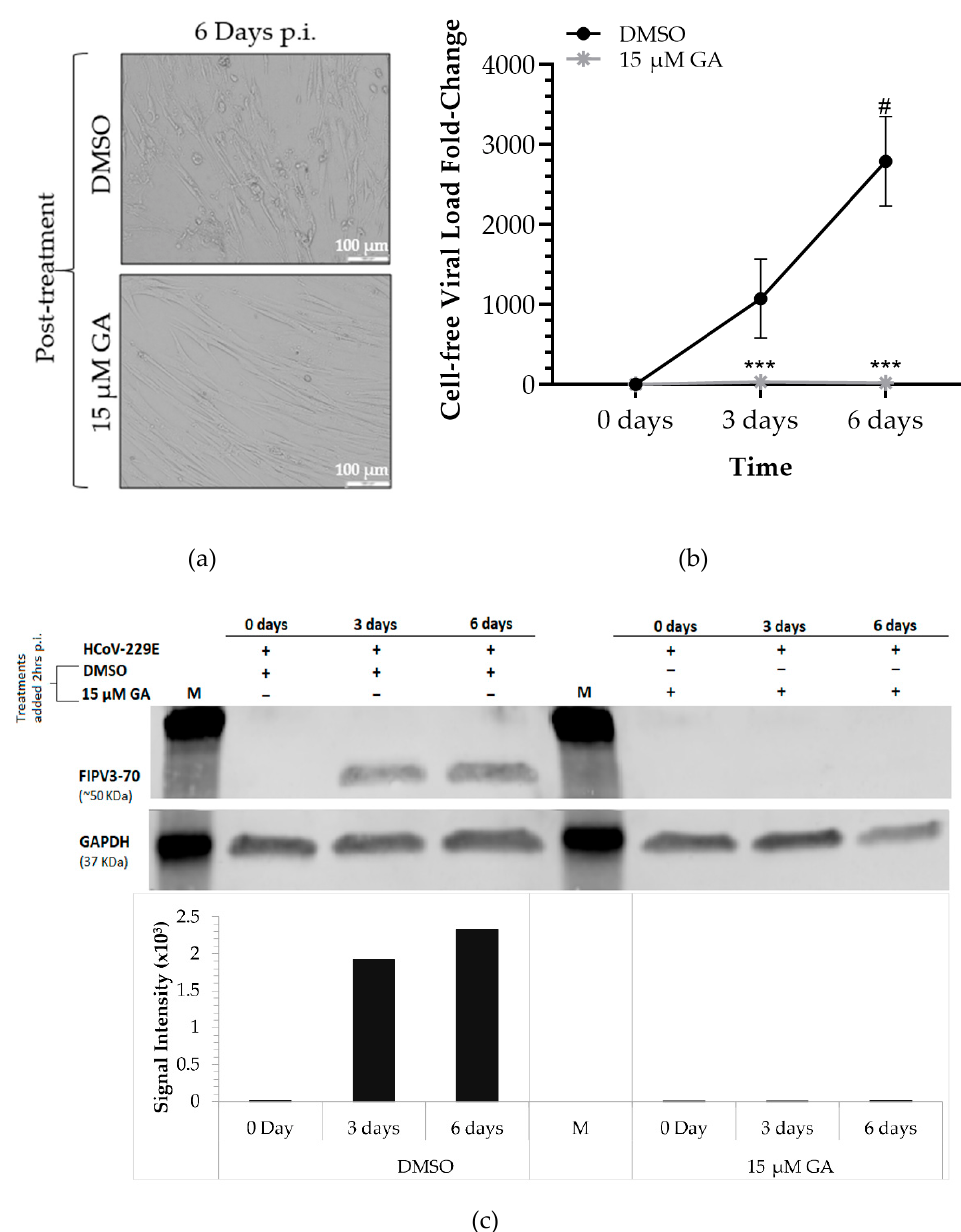
Figure 2. Post-treatment of Ginkgolic acid in HCoV-229E-infected MRC-5 cells. ( a ) Representative light microscopy images obtained on day 6 of MRC-5 cells treated post-infection with DMSO or 15 µ M GA; ( b ) viral load fold-change detected from the supernatant of infected MRC-5 cells, post- treated with DMSO or 15 µ M GA, indicated time points compared to day 0; ( c ) Western Blot analysis of cells treated post-infection using antibodies directed against coronaviruses and GAPDH. M: Chameleon 800 Pre-stained Protein Ladder. Signaling intensities of bands for FIPV3-70 antibody have been normalized to GAPDH. Mixed-model ANOVA of post-treatment experiments [Interaction (Time*Treatment): [ p < 0.01]; Treatments (DMSO or 15 µ M GA): [ p < 0.001], and Time (0, 3, 6 days p.i.): [ p < 0.01]). # p < 0.001, represents the significant increase in viral load at day 6 p.i. under the respective treatment when compared to day 0; *** p < 0.001 represents a significant decrease in the supernatant viral load of cells treated with 15 µ M GA compared to the DMSO-treated cells at days 3 and 6